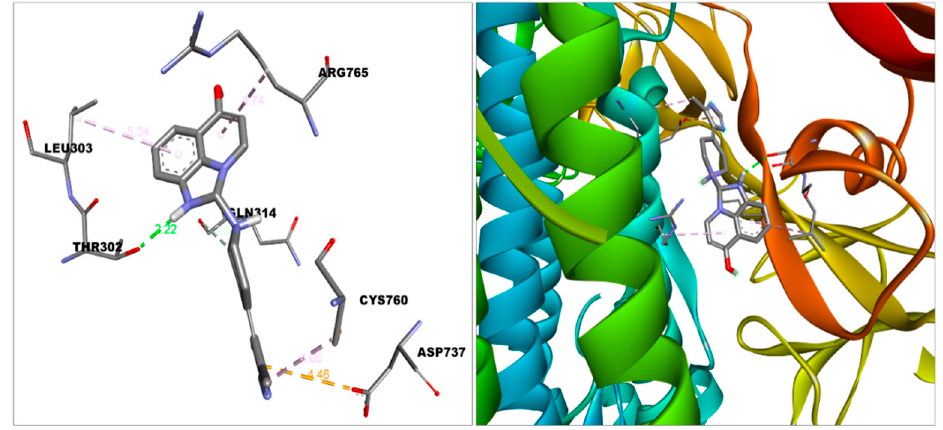
Figure 7. In the binding pocket of S protein, imidazoquinolinone is docked. Discovery Studio visualizer was used to build this figure. (http://accelrys.com/products/collaborative-science/biovia-discovery-studio/visualization-download.php).